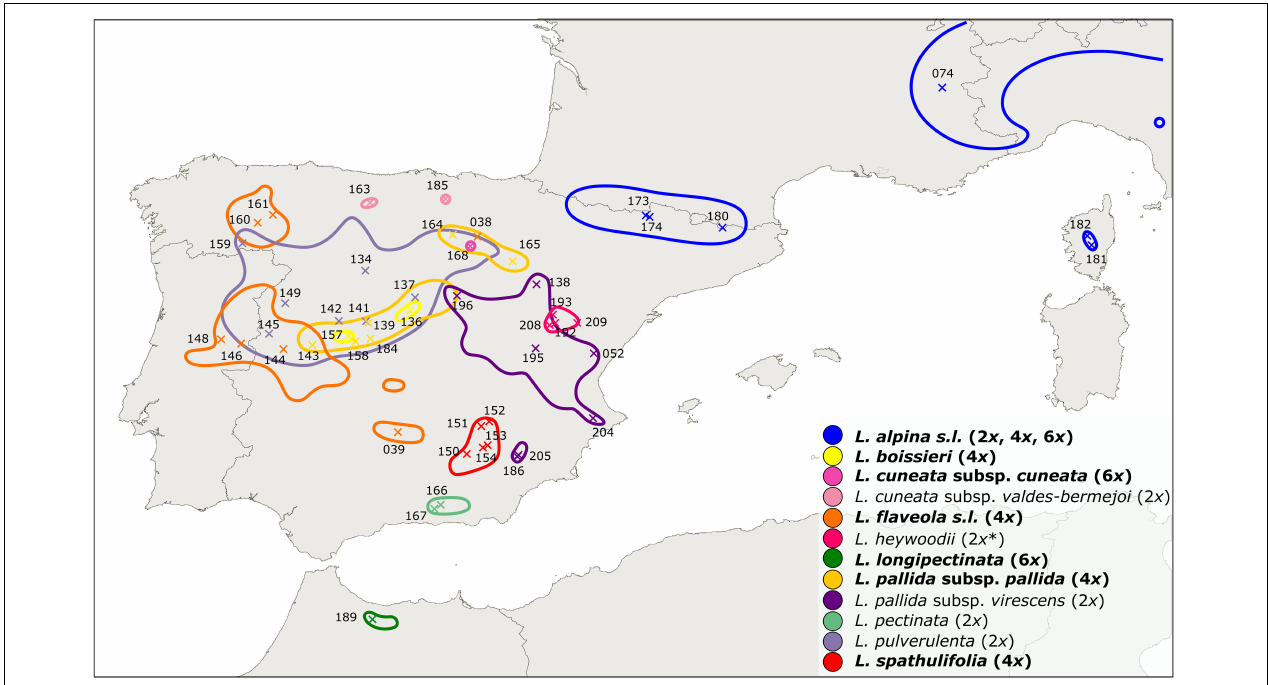
FIGURE 1 | Distribution map of Leucanthemopsis taxa in the western Mediterranean as inferred from literature and herbarium records ( Supplementary Figure 2 ; Supplementary Data Sheet 4 ). Taxa in bold are polyploids or include polyploid populations and the corresponding ploidy levels follow the names. * Diploid ploidy of L. heywoodii was inferred by our flow-cytometric measurements, whereas Pedrol (2019) reported this taxon to be tetraploid. × , geographic position of the populations included in the present study with corresponding IDs (“LPS” in Supplementary Data Sheet 1